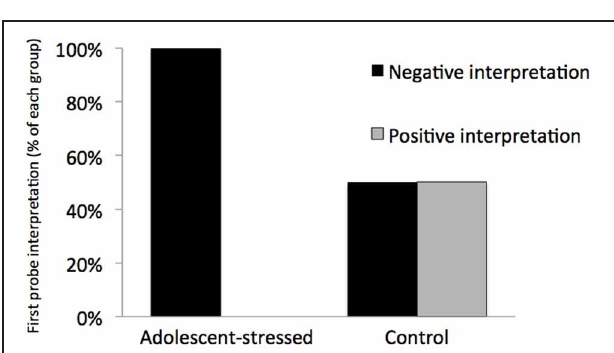
FIGURE 5 | Interpretation of a novel ambiguous stimulus on the first day of an ambiguous judgment test for cognitive bias. All animals that experienced stress during adolescence interpreted the ambiguous cue as negative, indicating a long-term negative cognitive bias, while control animals were equally likely to interpret the cue as positive or